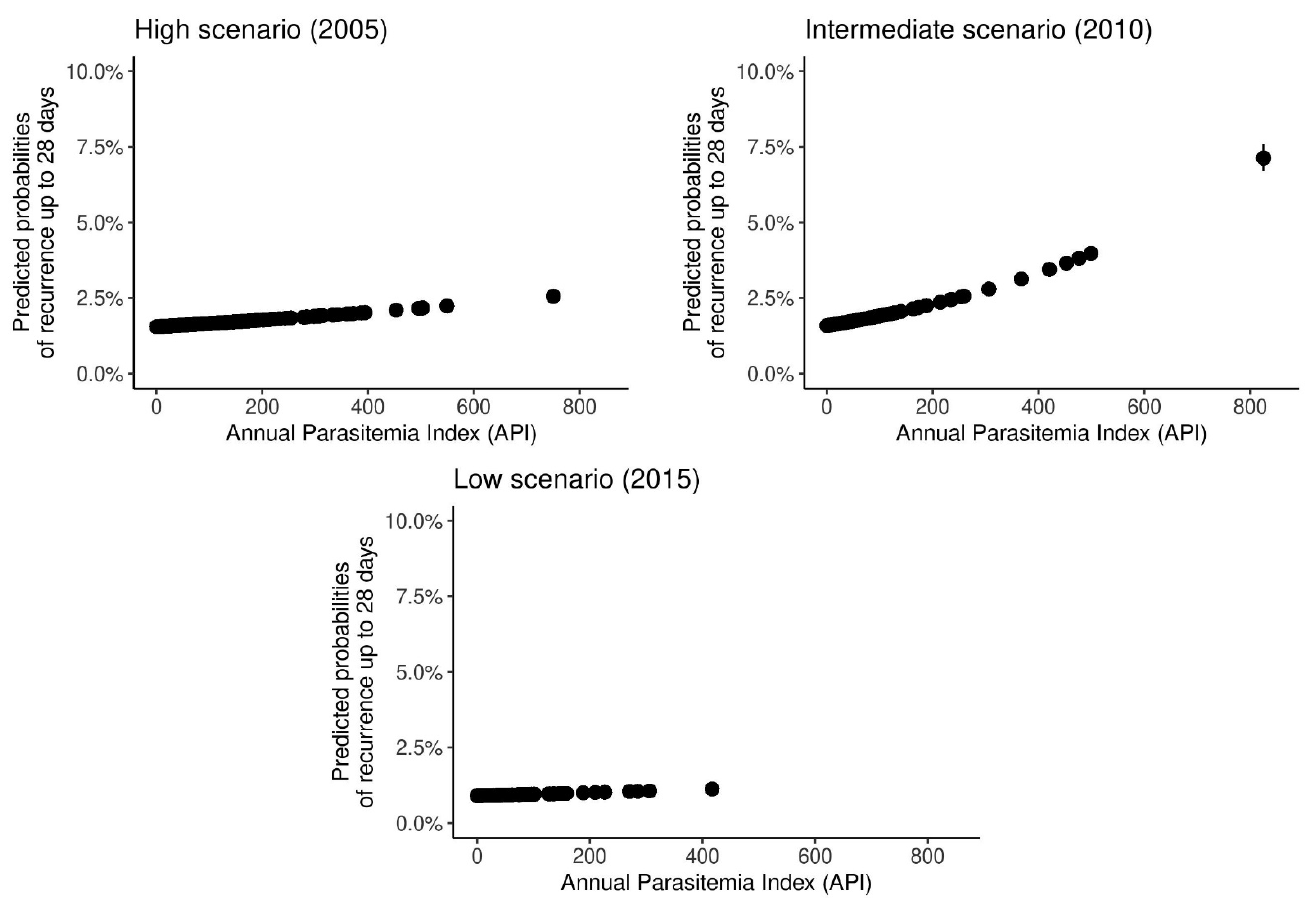
Figure 5. Predicted probability of recurrence up to 28 days according to the annual parasitemia index (API) in the Brazilian Amazon in 2005, 2010, and 2015.